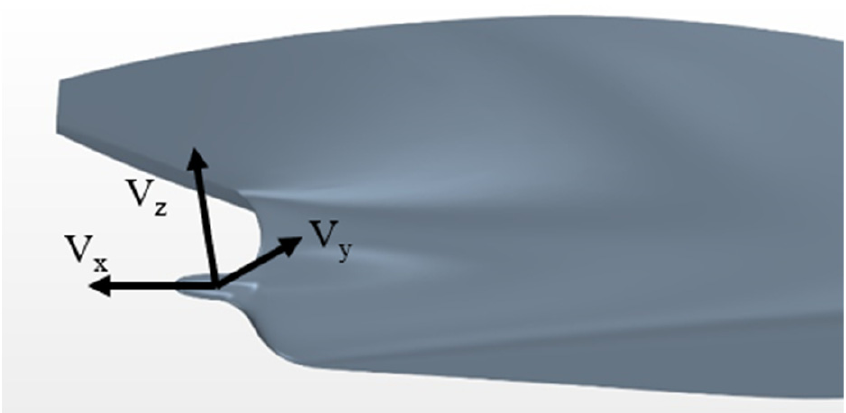
Figure 6. Coordinate system of the CFD calculation.